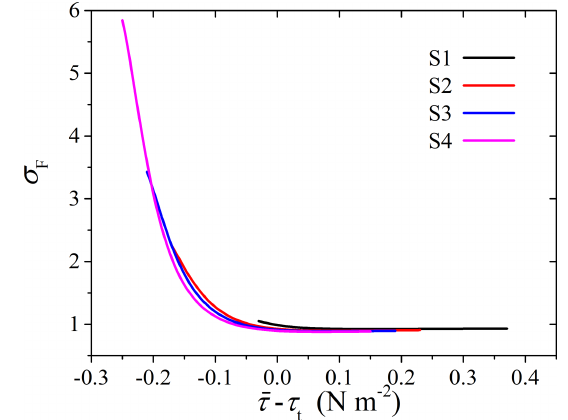
Figure 7. Relationship between σ F and excess surface shear stress ( τ − τ t